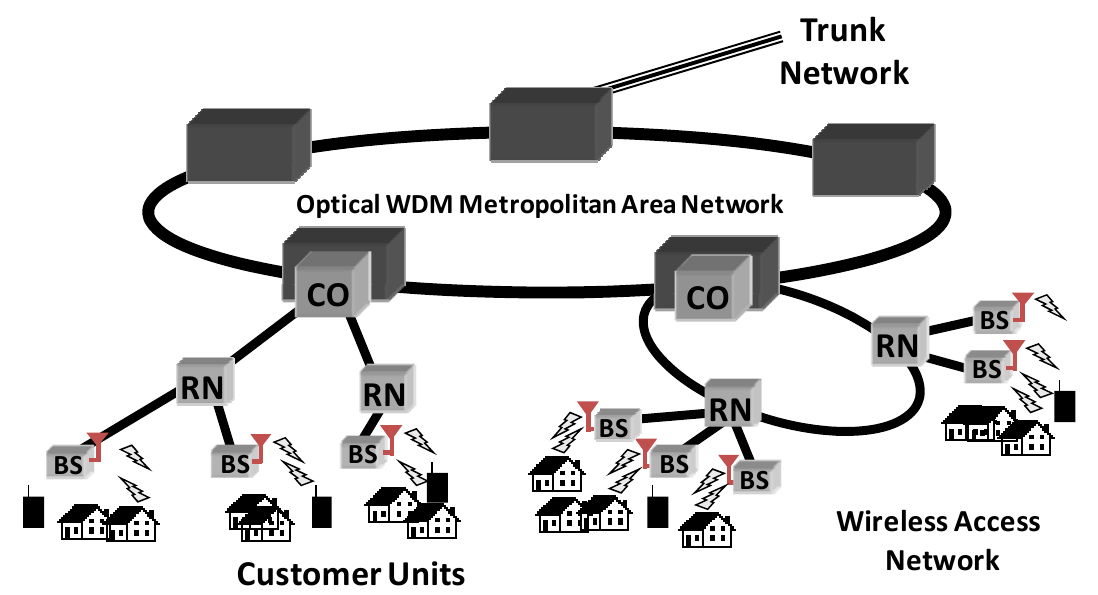
Figure 1. Fiber-wireless